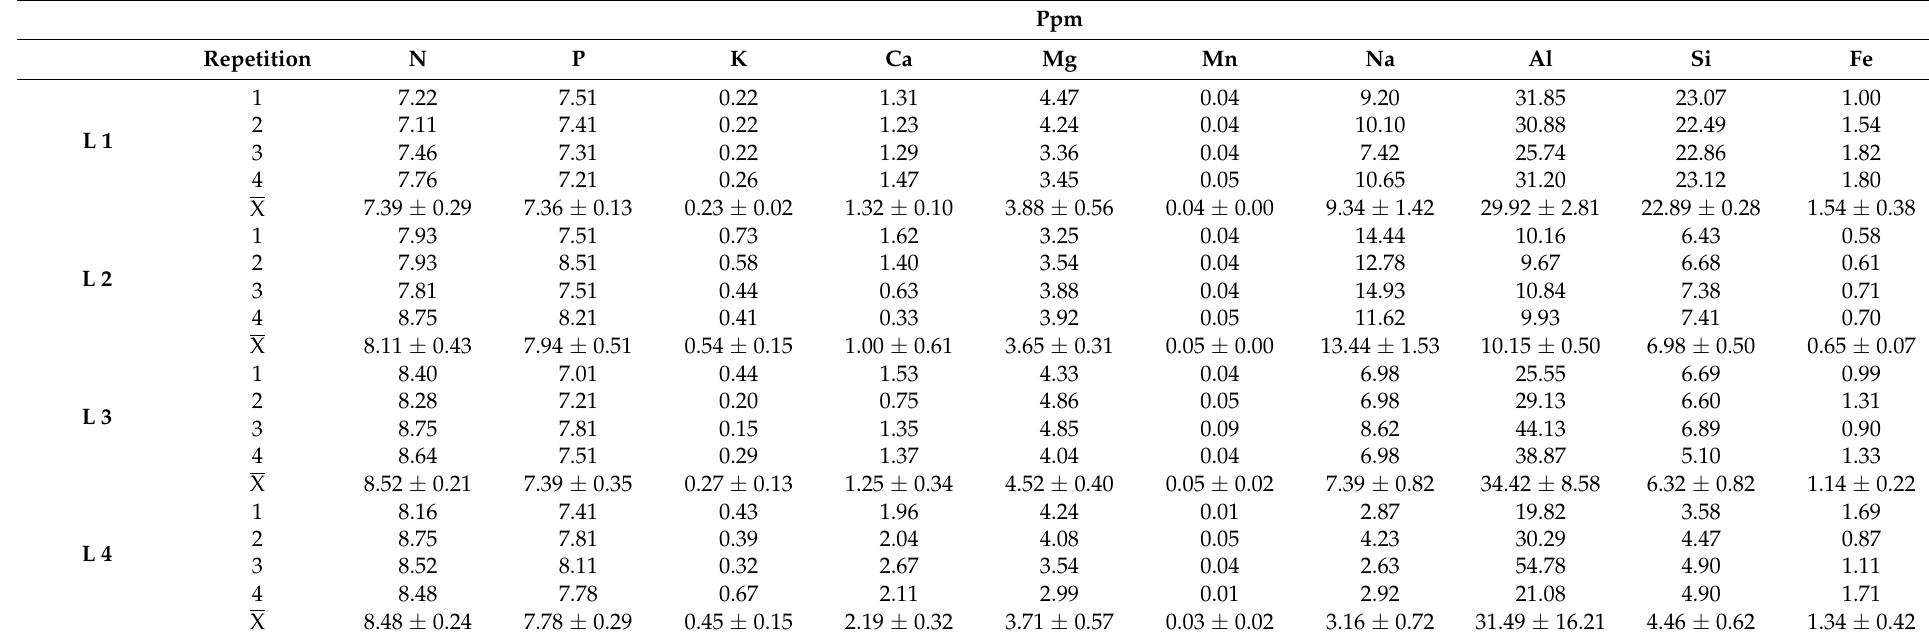
Table 6. Soil chemical composition in the four